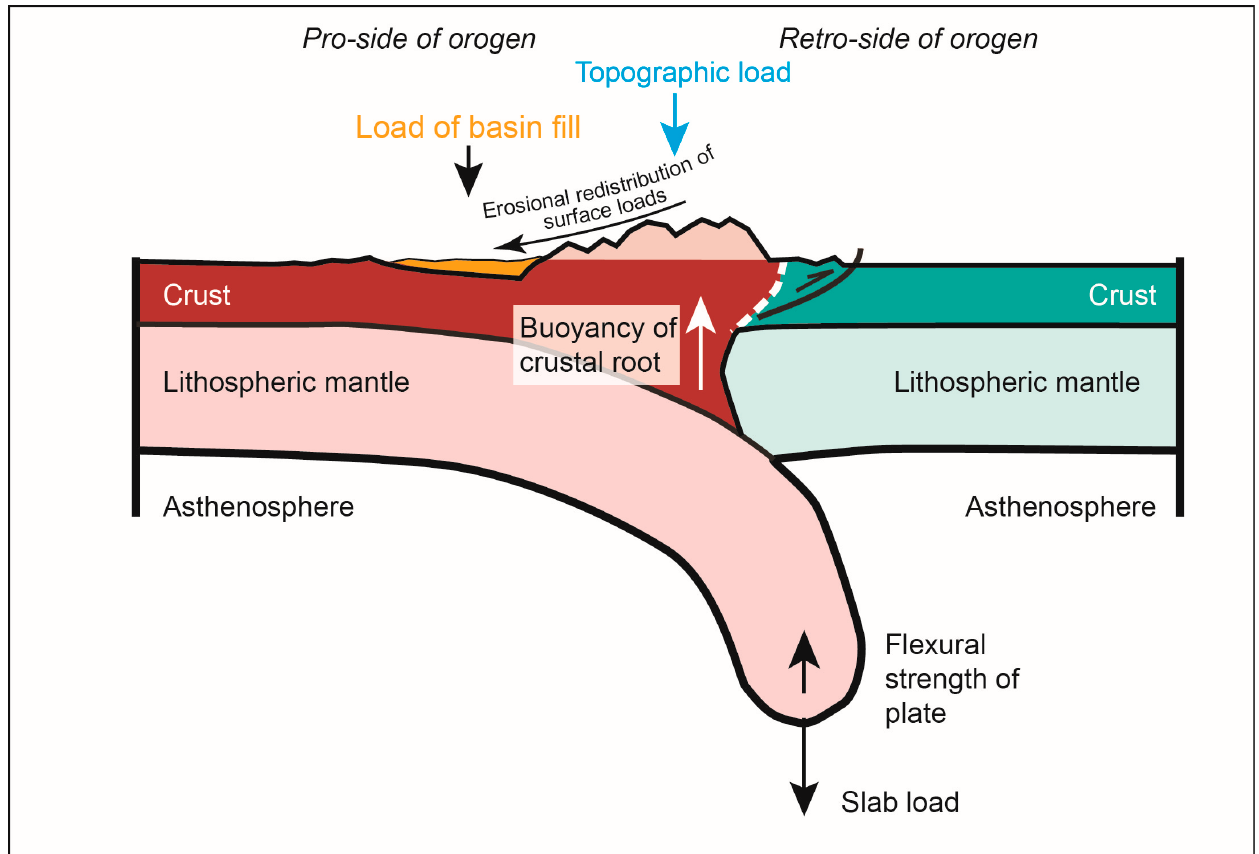
Figure 1. Orogenic and basin loads and flexure of a foreland plate. Modified from Schlunegger and Kissling [26].